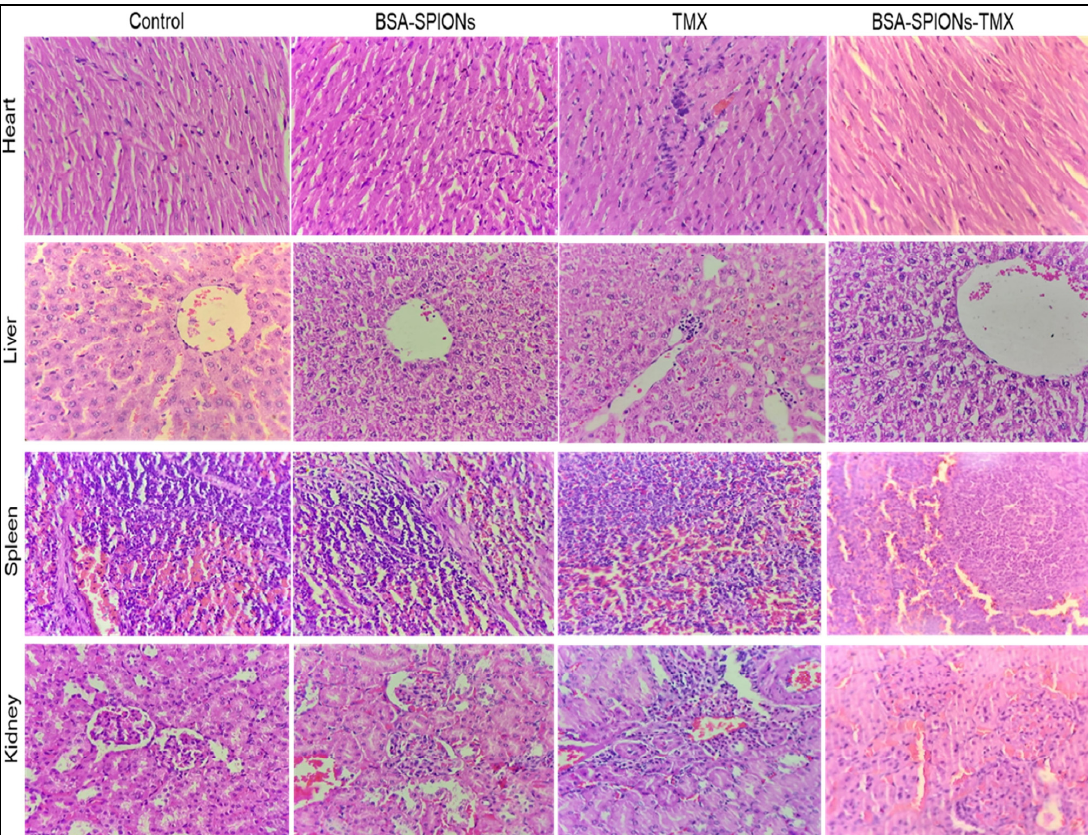
Figure 10. Representative photomicrographs of histopathology (40x) of a cross-section of the heart, liver, spleen, and kidney from the control, BSA-SPIONs-, TMX-, and BSA-SPION-TMX-treated groups.